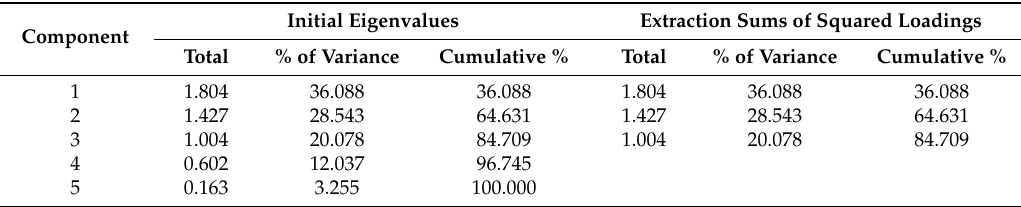
Table 2. Principal component; total variance